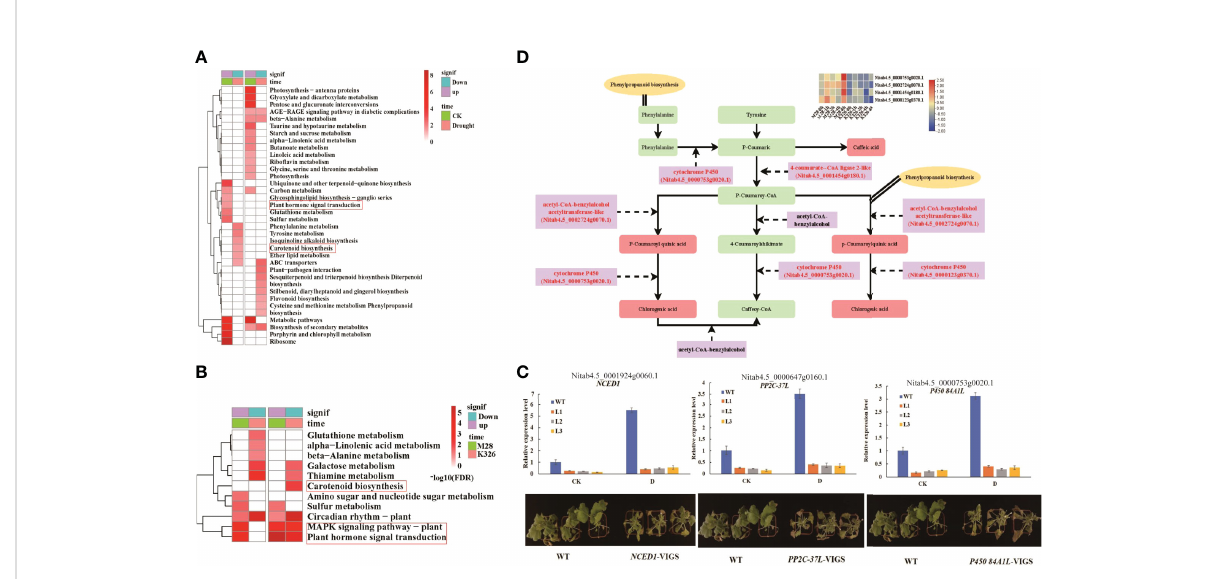
FIGURE 5 Integrated analyses of transcriptome and metabolome. (A) KEGG pathway enrichment analyses of genes that were up- or down-regulated before (CK) or under drought treatment. (B) KEGG pathway enrichment analyses of up- and down-regulated genes in K326 or M28 under drought treatment. (C) Relative expression levels (up) and phenotypes (down) of VIGS-mediated knock-down of gene NCED1 , PP2C-37L and P450 84A1L before or post drought treatment. (D) Overview of DEGs and metabolites involved in “ Phenylpropanoid biosynthesis ” and “ Flavonoid biosynthesis ” . The red representing differentially expressed genes and differential metabolites that are signi fi cantly enriched in the pathways of Phenylpropanoid biosynthesis terms and Flavonoid biosynthesis pathway. Four differentially expressed genes with relative expression levels (FPKM value) in the M28 and K326 are shown in the